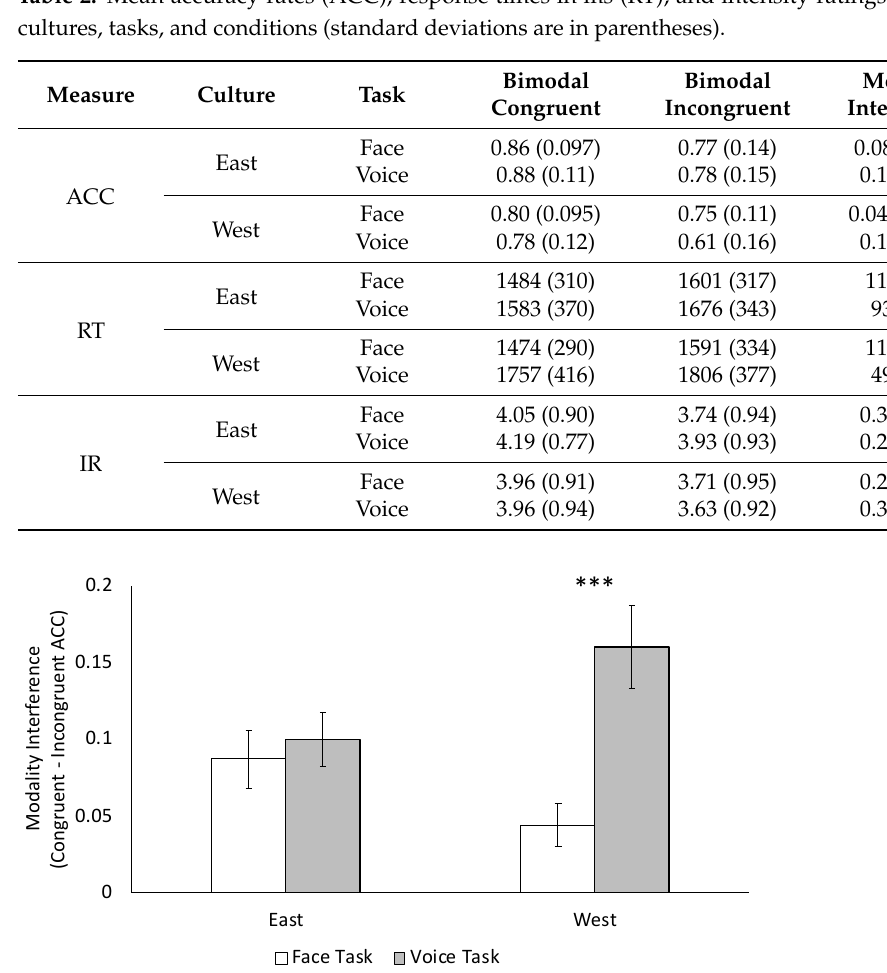
Figure 2. Modality interference effects in accuracy rates (bimodal congruent trials minus bimodal incongruent trials). A larger modality interference in the face task represents greater interference from the auditory modality, whereas a larger modality interference in the voice task represents greater interference from the visual modality. Chinese-English bilinguals experienced a larger modality interference in the voice task than in the face task for the emotional information from the West (i.e., visual interference). Error bars represent standard error. *** p < 0.001.